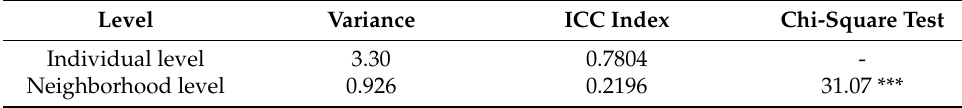
Table 3. Results of variance estimation in the null